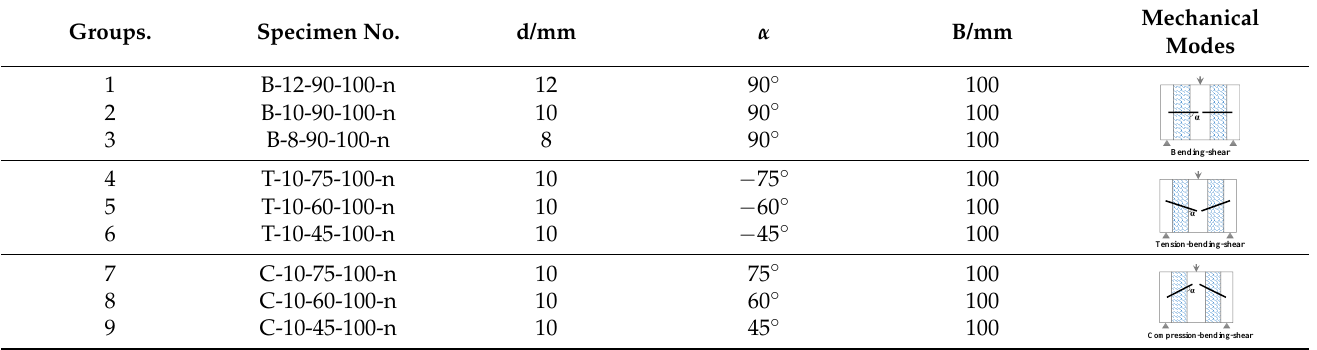
Table 1. Parameter of specimens.